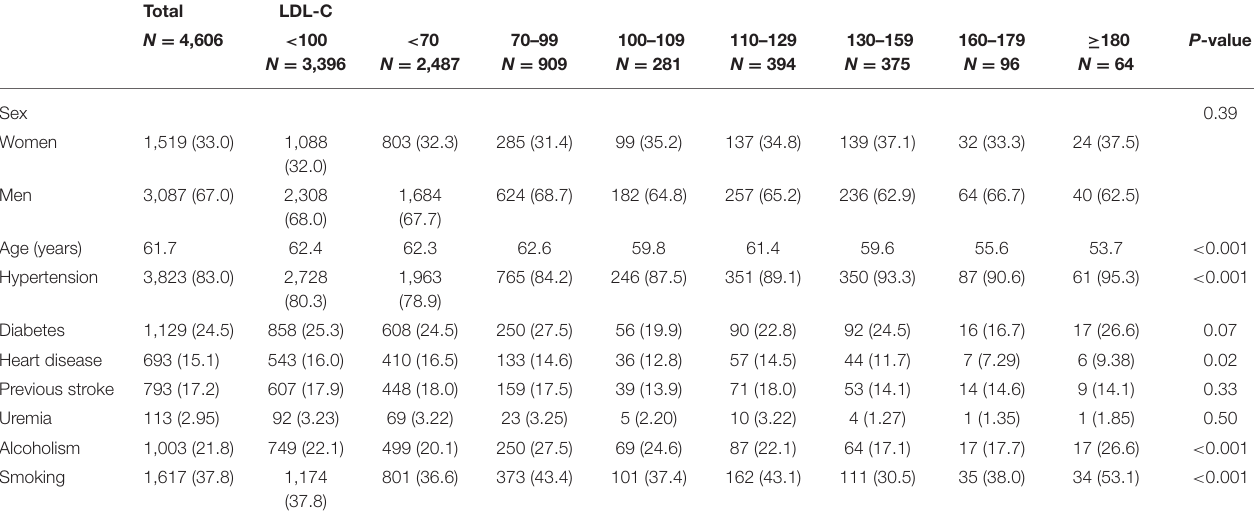
TABLE 3 | Baseline characteristics of the study population in TSR, n (%).